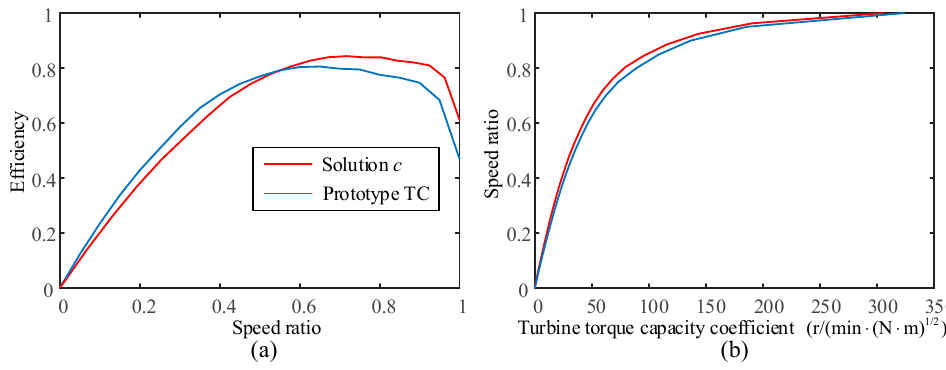
Figure 15. Basic characteristics of solution c . ( a ) Efficiency; ( b ) Loading characteristics.